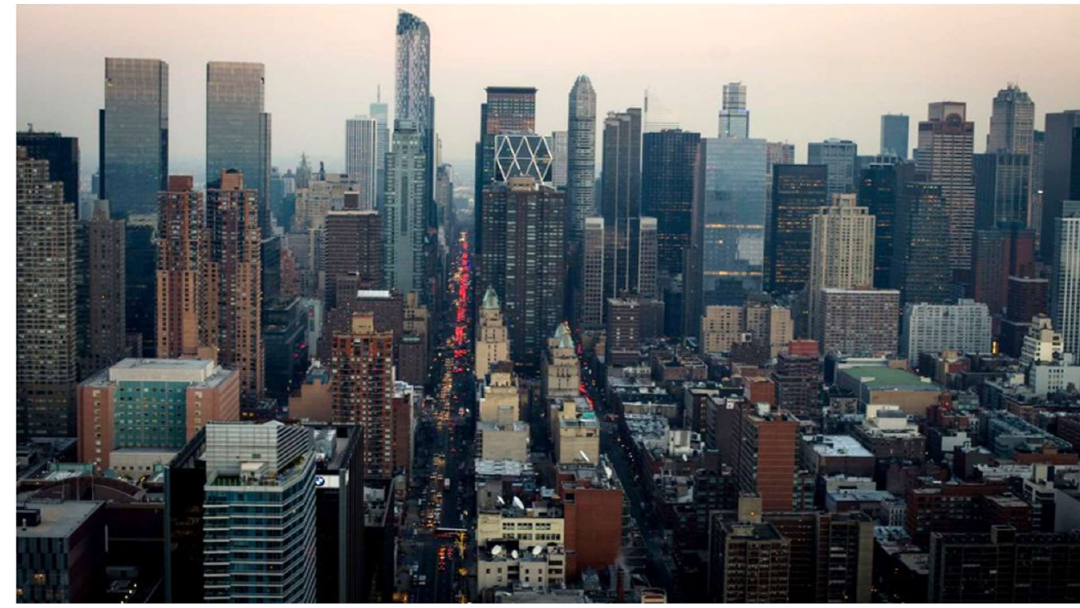
Figure 2. The Billionaire’s Row [9].